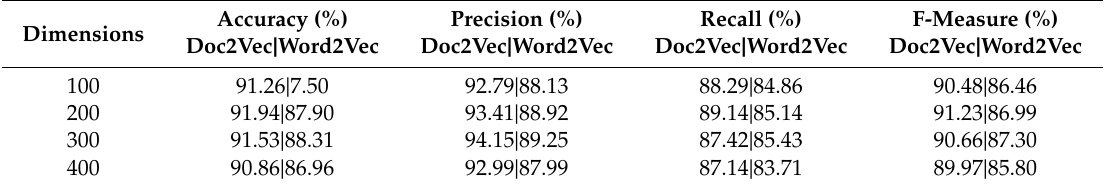
Table 4. Performance of Doc2Vec vs. Word2Vec for pornographic website classification.